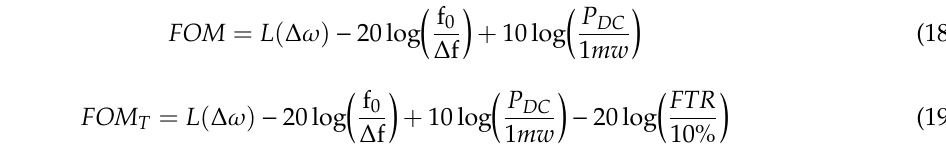
Table 2. Comparison of the proposed VCO with other works. Ref.